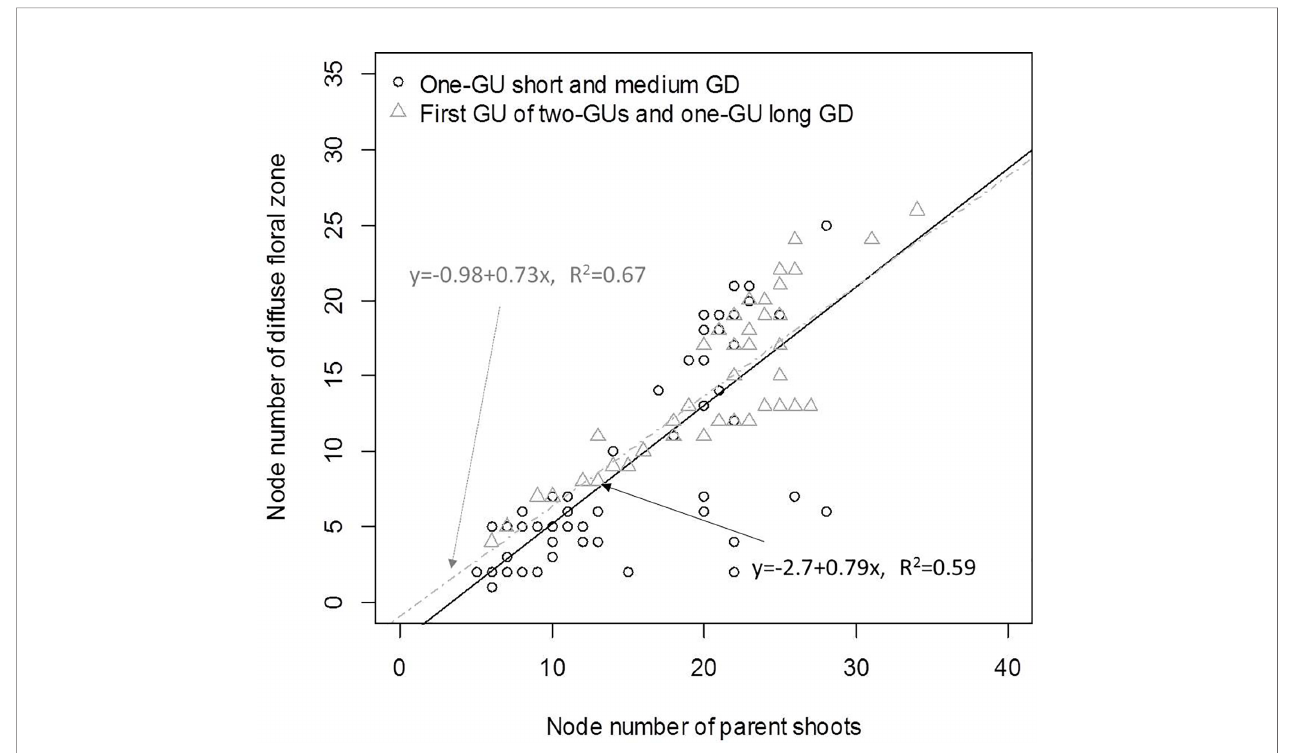
FIGURE 7 | Linear correlation between the length of the diffuse fl oral zone (state S1 in the model for one-GU with short and medium GD) and the total shoot length of the one-GU with either short or medium GD shoots, and the length of the diffuse fl oral zone (state L1 in the model for one-GU long GD and two-GUs) and the length of fi rst GU (L0 and L1) for two-GU and one-GU long GD shoots. Here the lengths are the number of nodes. The correlation coef fi cients (R 2 ) were calculated only for the shoots with a diffuse fl oral